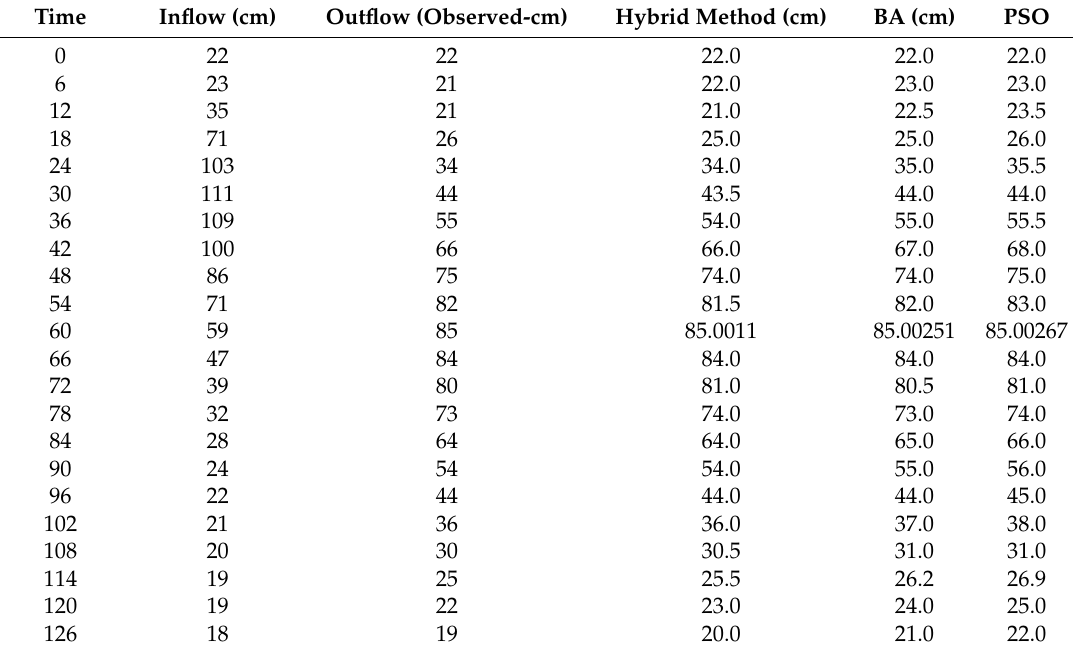
Table 7. Inflow and outflow for flood routing.